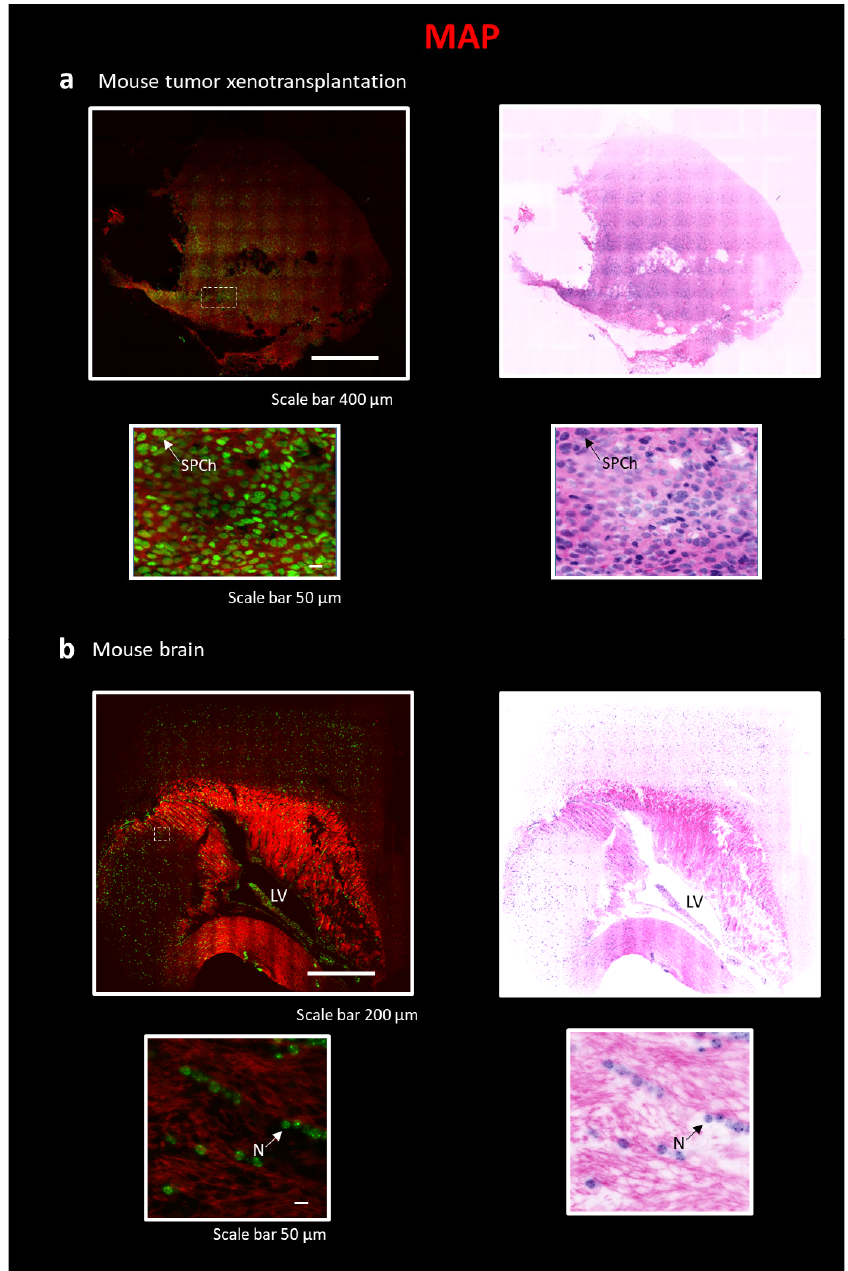
Figure 4. Reconstruction of tissue sections using the combination of MAP technique and LSM. All